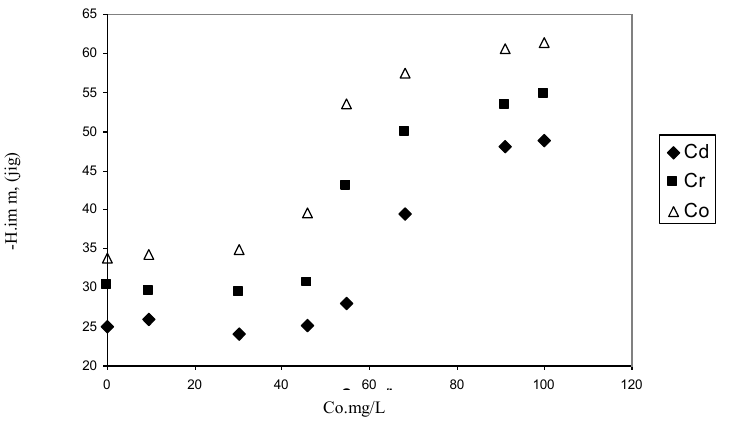
Figure 5. Immersion enthalpies for Cr 3+ , Cd 2+ , and Co 2+ aqueous solutions ions concentration at pH 5.0, T= 298